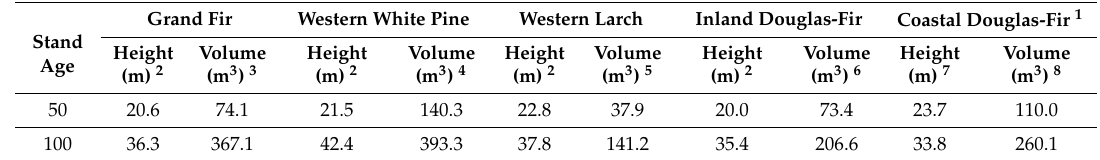
Table 1 . Grand fir height and total volume yield compared to associated species in the US Inland Northwest. All yields are from yield tables of fully stocked stands.